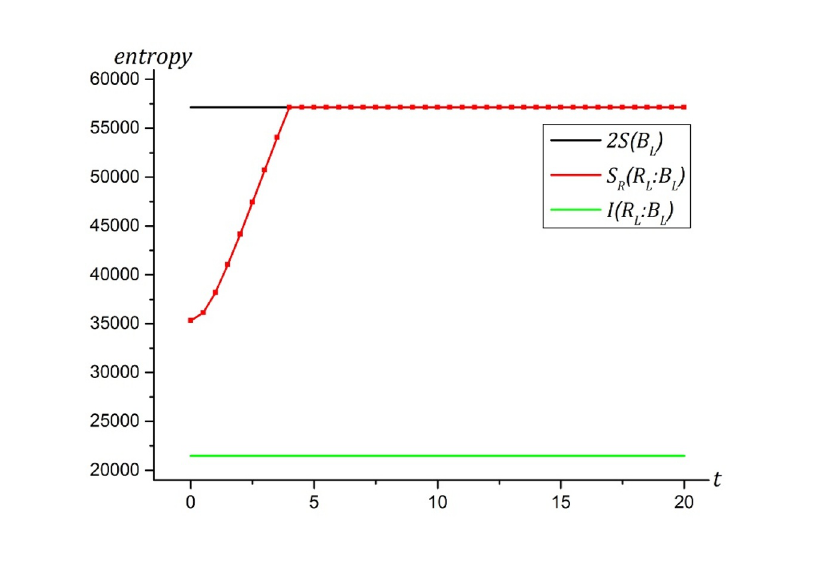
Figure 18 . Reflected entropy S R ( R L : B L ) as a function of time t . We pick b = 0 . 01 , φ r = 100 , S 0 = c = 20000 and (cid:15) UV = 0 . 01 . It is calculated that the upper bound 2 S ( B L ) = 57146 . 50 and the lower bound I ( R L : B L ) = 21479 . 99